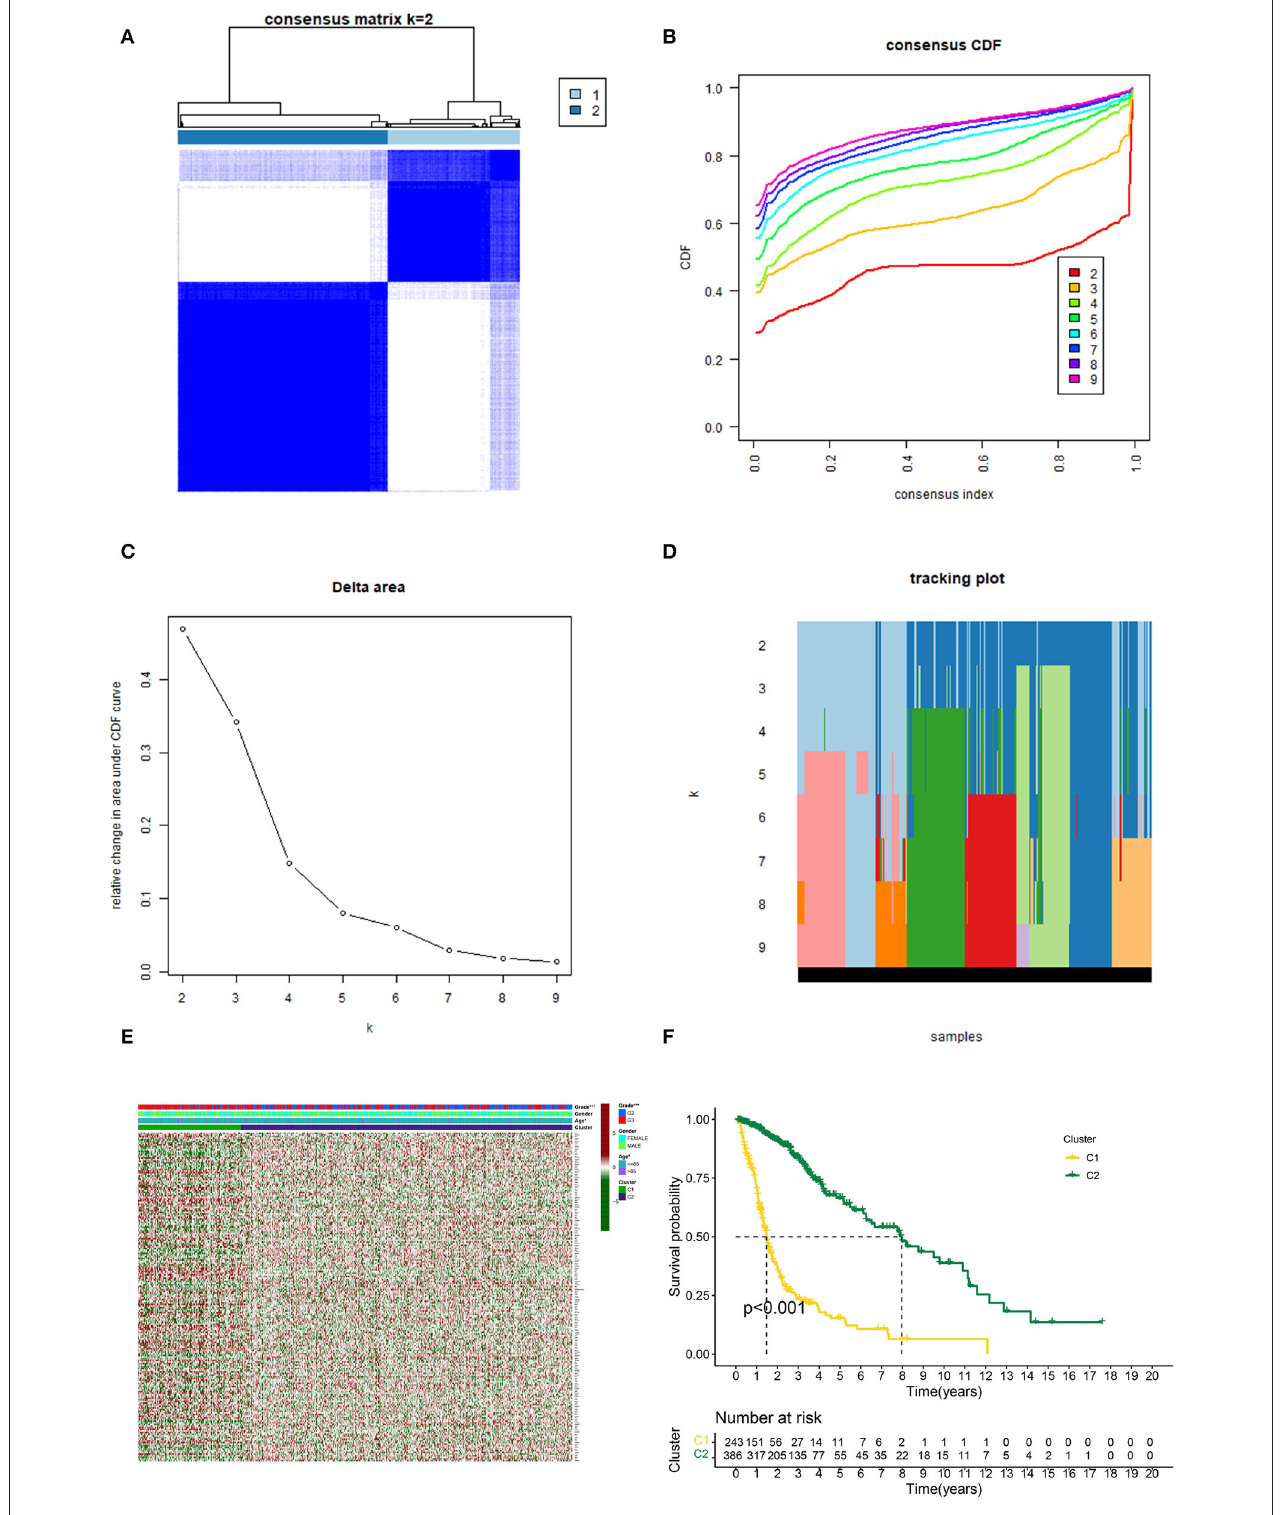
FIGURE 2 | Consistent cluster analysis of gliomas. (A) Consensus clustering matrix with k = 2. (B) Cumulative distribution function (CDF) for consistent clustering at k = 2–9. (C) For k = 2–9, the relative change in the area under the CDF curve. (D) Sample distribution for k = 2–9. (E) Heatmap and clinicopathologic characteristics of the two clusters established by the consensus expression of the m7G RNA methylation regulators (Red for high expression level, green for low expression level). (F) Comparison of Kaplan–Meier OS rates for overall survival (OS) curves in the two clusters (* p < 0.05, *** p < 0.001).